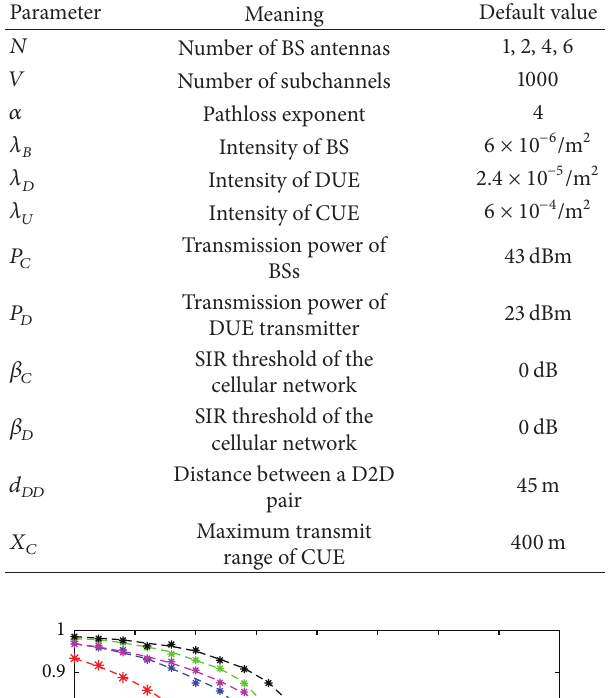
Table 1: Parameter assumptions.